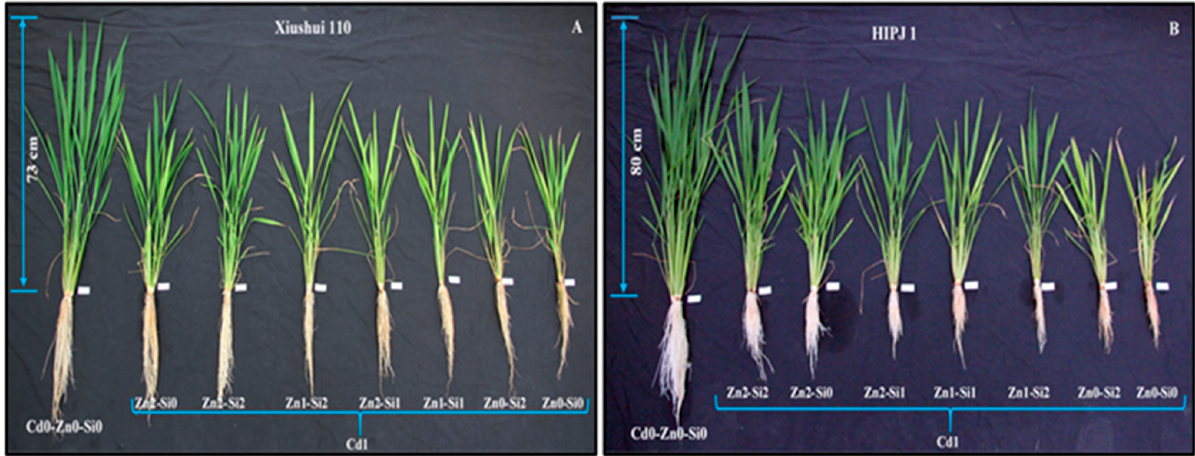
Figure 1. Differences in growth between two rice genotypes, Xiushui 110 ( A ) and HIPJ 1 ( B ) after 30-d treatment. Cd0 (0